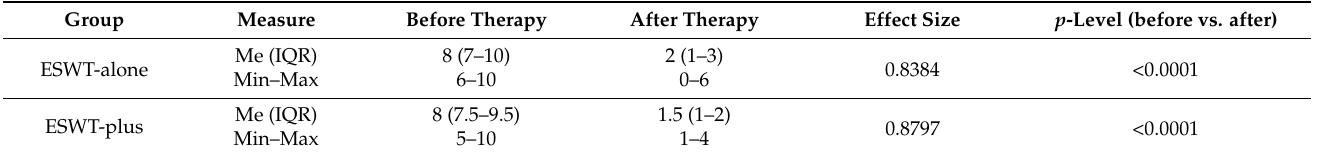
Table 4. Assessment of pain intensity according to the VAS scale before and after therapy in the compared groups.